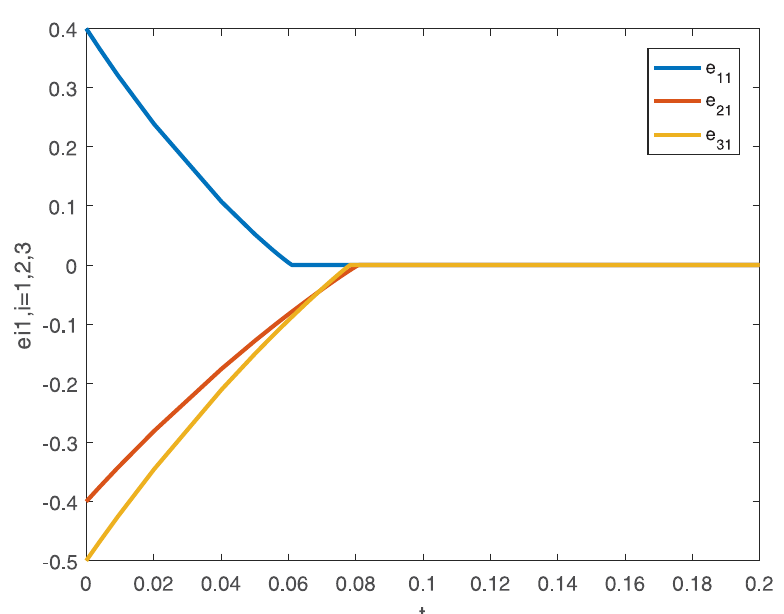
Fig 7. The first dimensional error curves ( e controller (8).